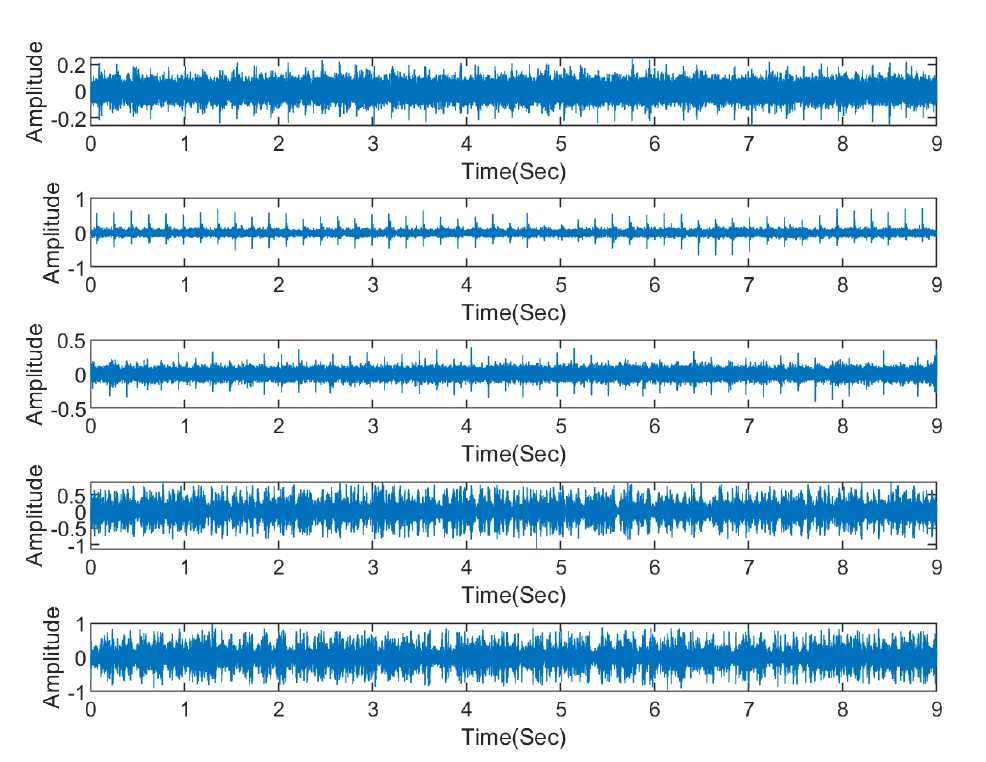
Figure 4. Selected examples of cyclic impulsive signals corresponding to faulty idlers.